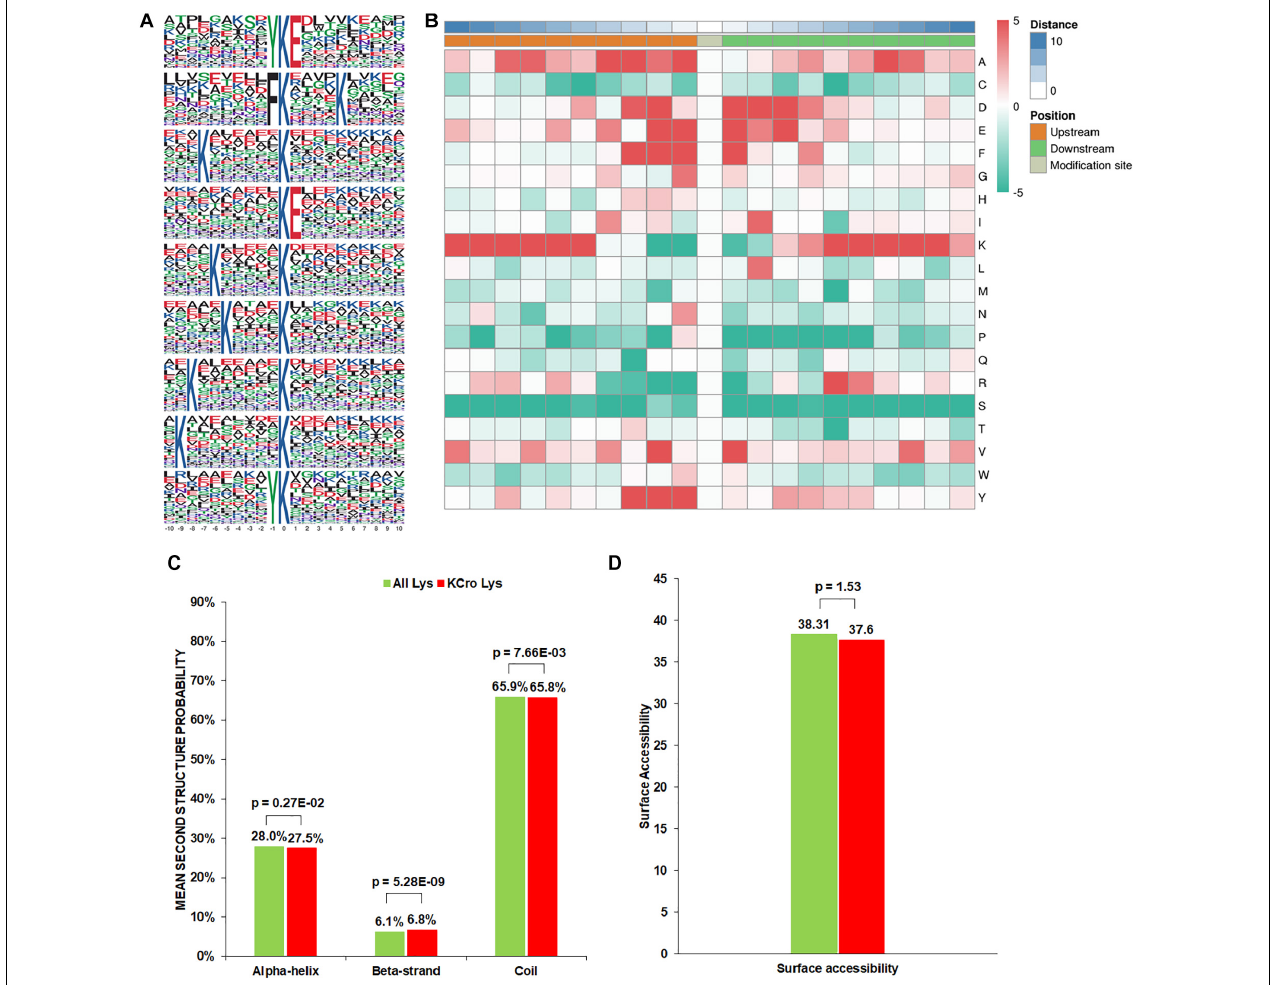
FIGURE 1 | Properties of the Kcr peptides in B. cinerea . (A) Crotonylation sequence motifs for ± 10 amino acids surrounding the Kcr sites. (B) Heatmap of the amino acid compositions of the Kcr sites demonstrating the frequency of certain amino acids around the modified lysine. Red indicates high frequency and green means low frequency. (C) Probabilities of Kcr in the structures of beta-strand, alpha-helix, and coil. (D) Predicted surface accessibility of Kcr